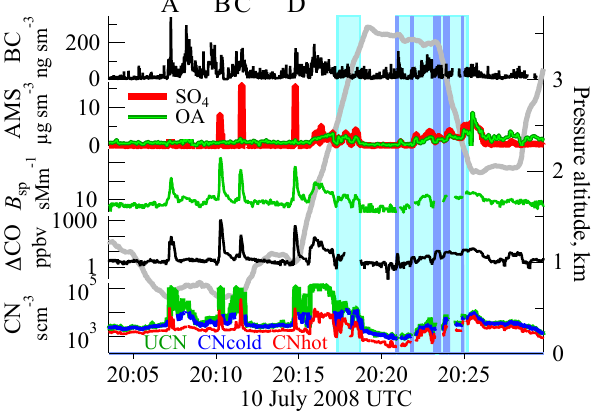
Figure 5. The oil sands plume as seen by in situ instruments on the DC-8. The light-blue region was when the plane was upwind of the facilities, while light brown indicates the plume. The plane flew parallel to the wind at 18:34, so no flux could be calculated. The gap at 18:43 is there because of the NO 2 and B ap spikes, which appear consistent with diesel truck traffic. The period from 18:25 to 18:28 was downwind of both mining operations and the town of Ft. McMurray. Scattering, B sp , is at 550nm, while absorption, B ap , is at